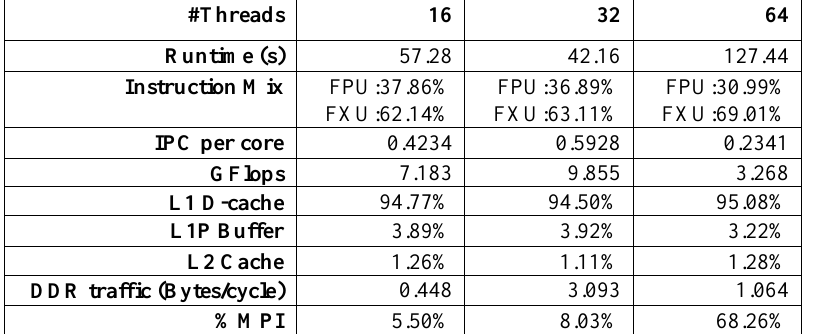
Table 3. Performance (per node) comparison of BT-MZ with Class D on 128